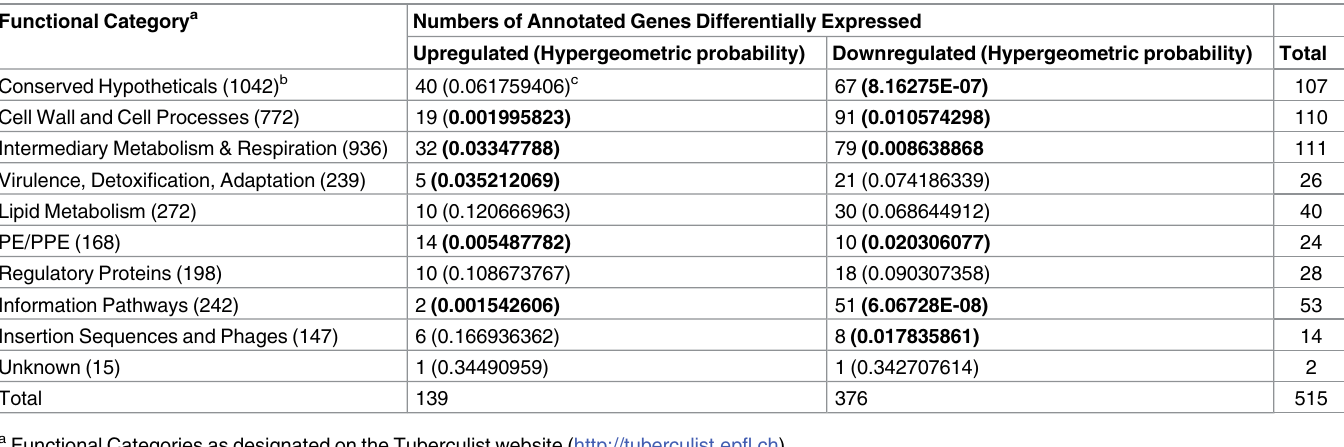
Table 1. Functional categories of differentially